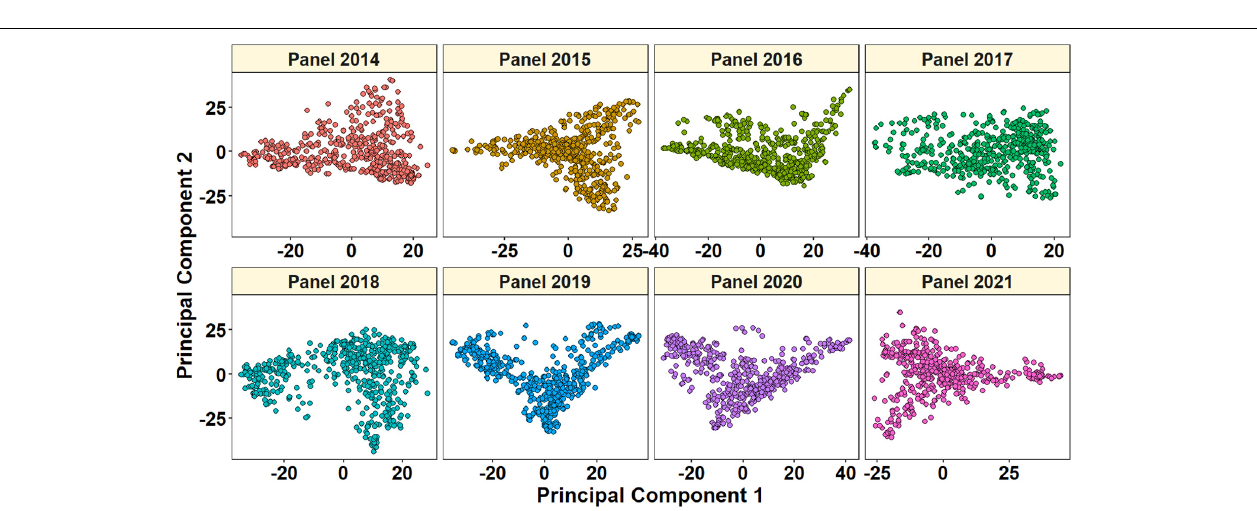
FIGURE 2 | Densities of 23,581 genotyping-by-sequencing (GBS) single-nucleotide polymorphisms (SNPs) in the reference bread wheat genome (RefSeq v1.0). The color key with marker densities indicates the number of markers within a window size of 10 Mb.